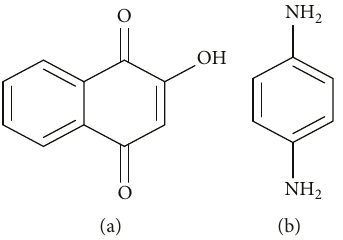
Figure 10: Lawsone structure (a) and PPD structure